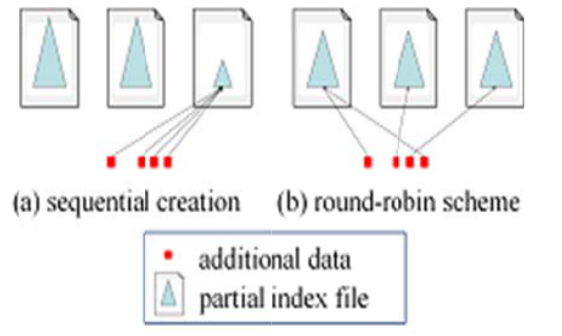
Fig. 1. File split xes for